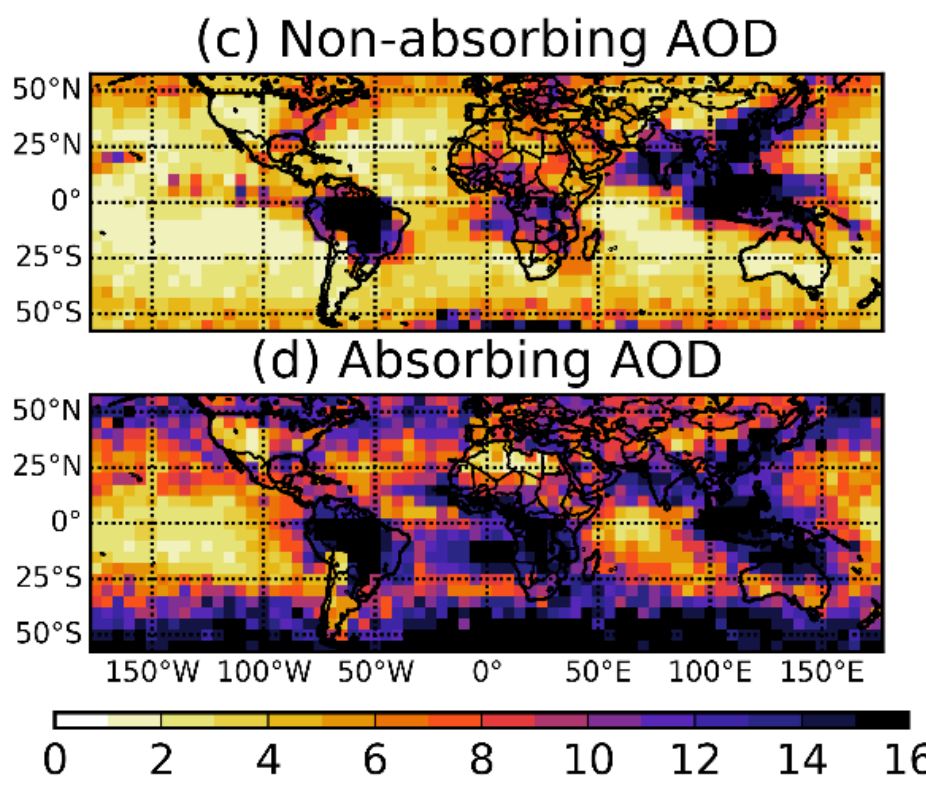
Figure A6. The minimum record lengths required to obtain stable seasonal climatology of ( a ) total, ( b ) nonspherical, ( c ) nonabsorbing, and ( d ) absorbing aerosol optical depths in Fall (September-October- November) within the predefined accuracy levels ( ± 0.01 AOD for ( a ), ± 0.004 for ( b ), and ± 0.005 for ( c ) and ( d